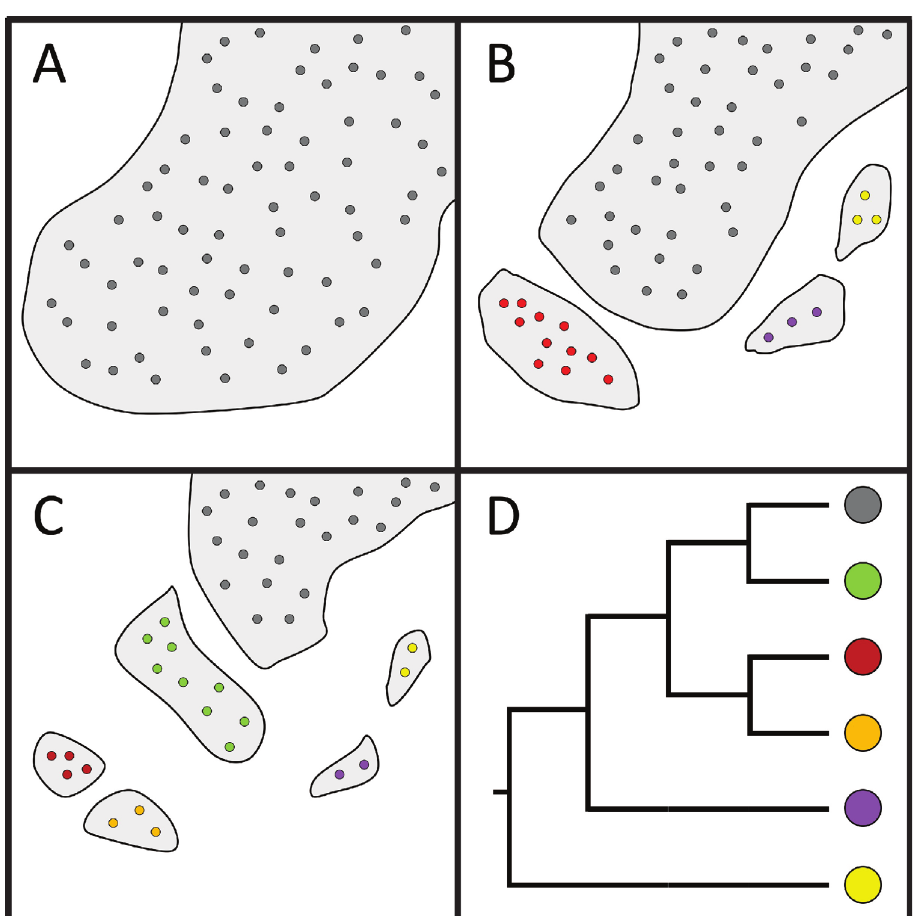
Figure 5. Biogeographic and phylogenetic expectations for a ‘vicariance by erosion’ scenario as hypoth- esized for the southern Cumberland Plateau. A–C Karst (gray) erodes and fragments over time, leading to the isolation and divergence of cave populations (colored circles) in the remaining patches of karst D A phylogeny consistent with the vicariance by erosion process, with taxa that diverge early distributed at the periphery of the eroding